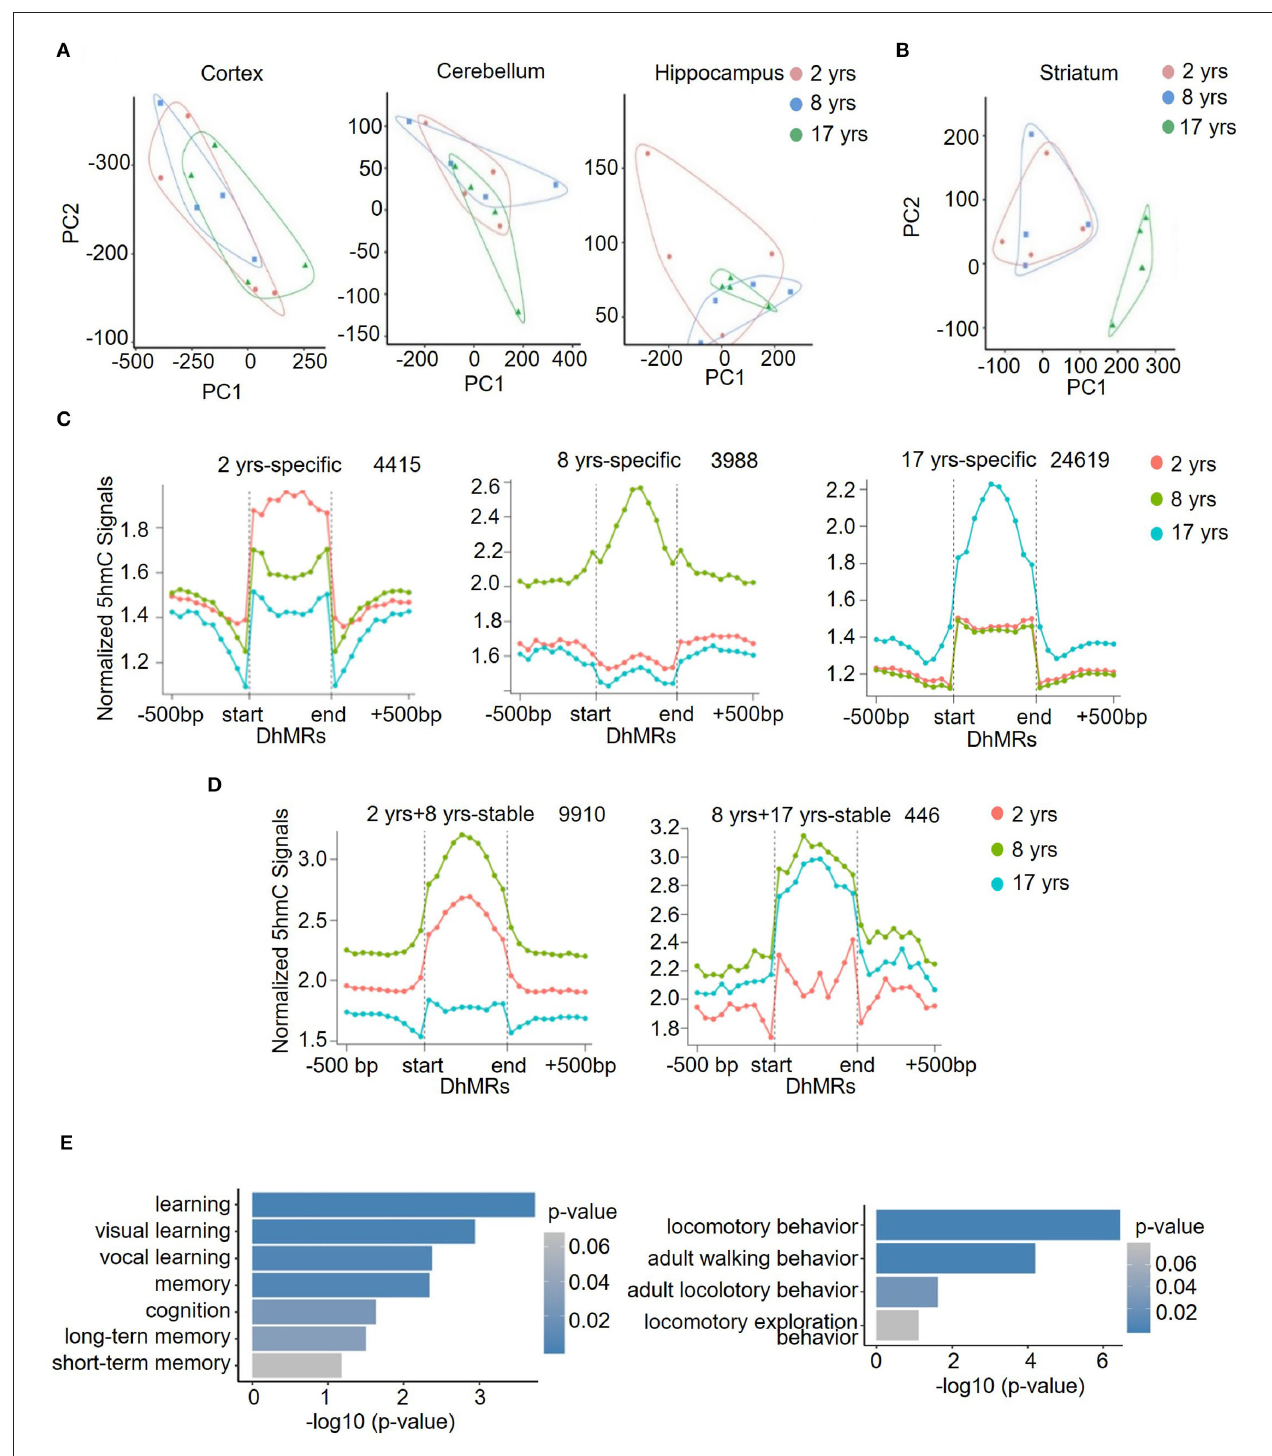
FIGURE 3 | Identification and characterization of striatum-specific DhMRs. Principal component analysis (PCA) results in the cortex, cerebellum, hippocampus (A) , and striatum (B) . (C) Dynamic 5hmC DhMRs in the striatum. A total of 4415 DhMRs were identified as 2 years-specific relatives to 8 years and 17 years groups, 3,988 DhMRs were identified as 8 years-specific relatives to 2 years and 17 years groups, and 24,619 DhMRs were identified as 17 years-specific relatives to 2 years and 8 years groups. (D) Stable 5hmC DhMRs in the striatum. A total of 9,910 DhMRs were identified as 2 years and 8 years stable relative to the 17 years group, and 446 DhMRs were identified as 8 years and 17 years stable relative to the 2 years group. The total numbers of DhMRs are indicated in the upper right-hand corner of each figure. (E) GO terms of 17-years-specific DhMRs enriched in cognition (left) and locomotory behavior (right) pathways. The y-axis lists the GO terms, and the x-axis indicates the significance p -value of